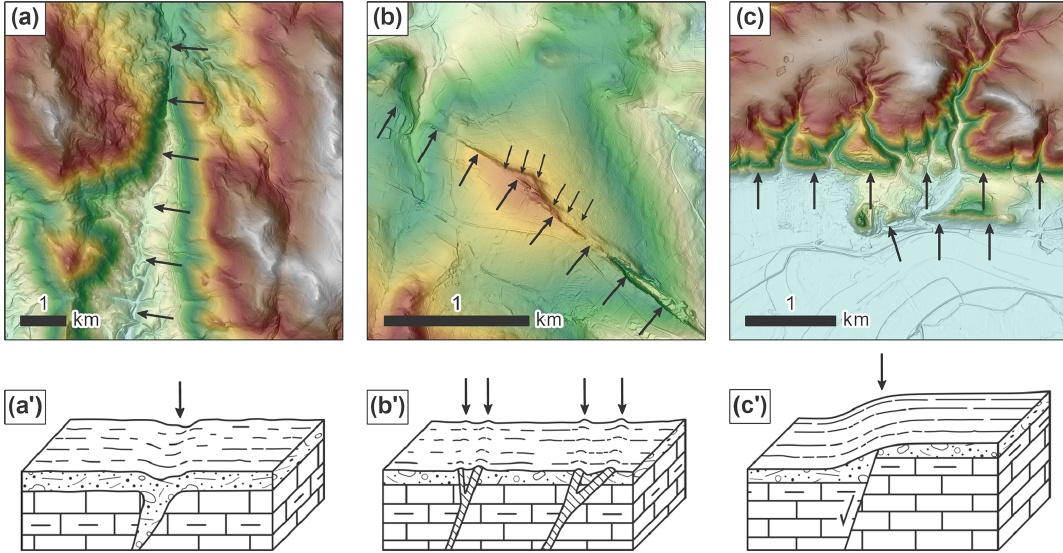
Figure 2. Map views (a) to (c) and sketches (a’) to (c’) illustrating the main lineament types encountered along the southwestern Bohemian Massif (sketches redrawn and modified from Fürst et al., 1978). Arrows depict the traces of lineaments. (a) – (a’) River valleys tend to form along zones of weakened bedrock commonly induced by faults and fractures. The example shown depicts the valley of the river Kollbach located in the Bavarian Forest. (b) – (b’) Linear ridgelines may form in cases where minerals, which are more resistant to erosion compared to the adjacent country rocks, have been precipitated within an open fault or fracture system. The best known example of this lineament type in the study area is the quartz lode of the Pfahl Shear Zone. (c) – (c’) Vertical movements along normal and reverse faults are usually expressed as abrupt, linear slope breaks. The example shown is located along the northwestern segment of the Danube Shear